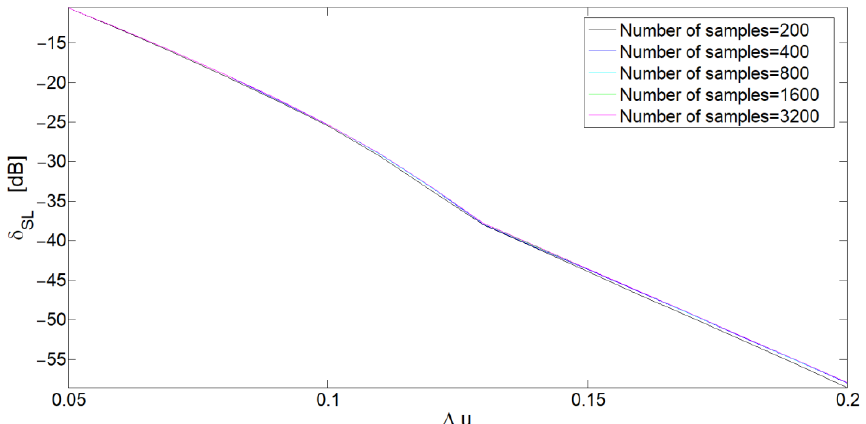
Figure 8. Maximum side lobe level δ SL (in dB) as a function of ∆ u , for N = 20, u MB = 0.16, and the number of sampling points varying from 200 to 3200.